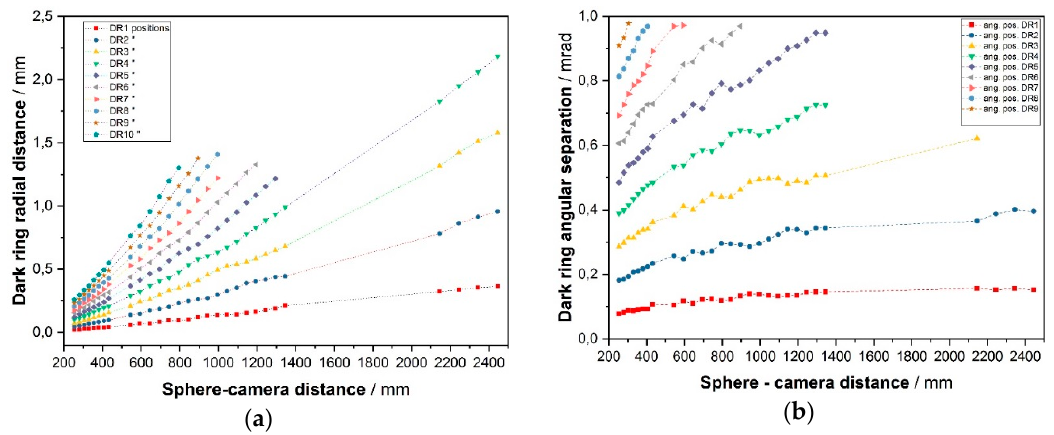
Figure 16. Dark ring radial distances ( a ) and corresponding angular separation as seen from the sphere ( b ), as a function of the distance to the sphere. Dark rings are numbered outwards: DR1, …, DR n .